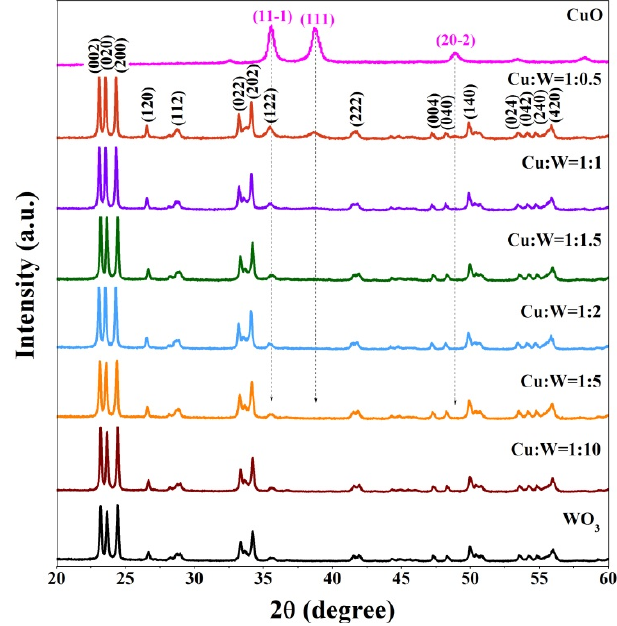
Figure 3. XRD patterns of the CuO/WO 3 composites with different Cu/W molar ratios.